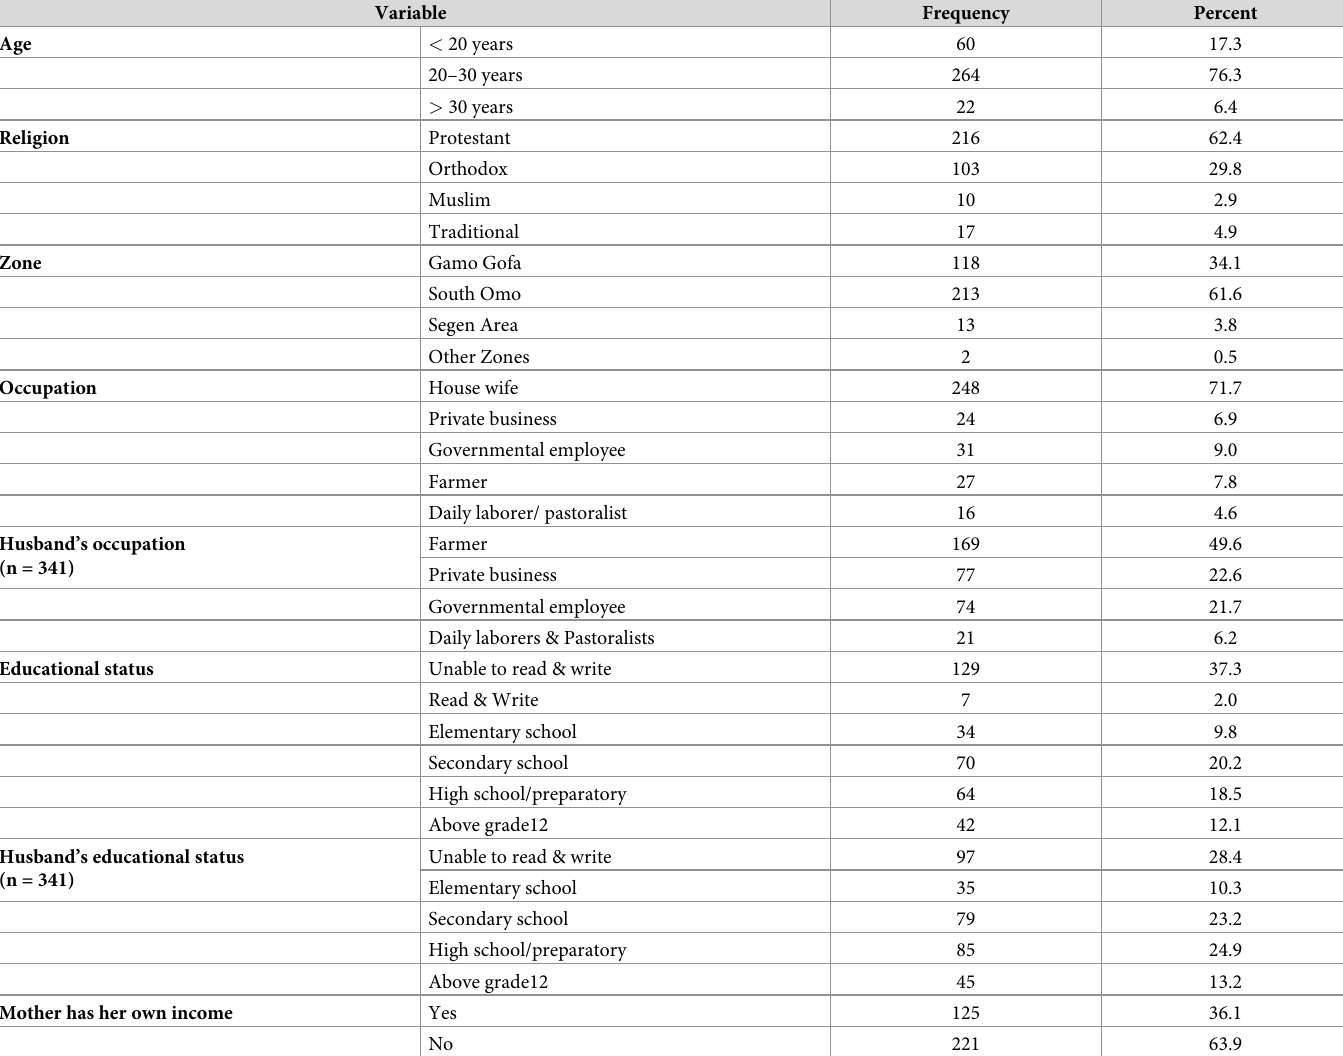
Table 1. Socio-demographic characteristics of the mothers of the neonates admitted to Arba Minch and Jinka General Hospital NICUs, Southwest Ethiopia, 2017 (n =